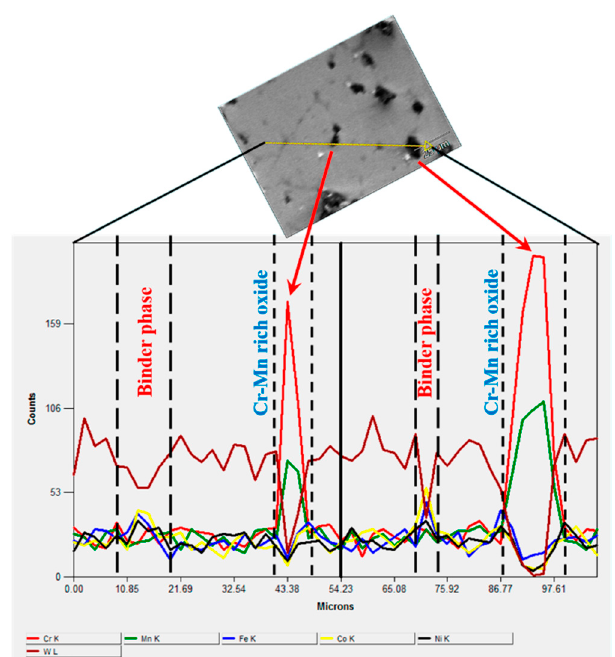
Figure 5. EDS line mapping across the tungsten grain, binder phase and Cr–Mn-rich oxide phase shown from the secondary image.